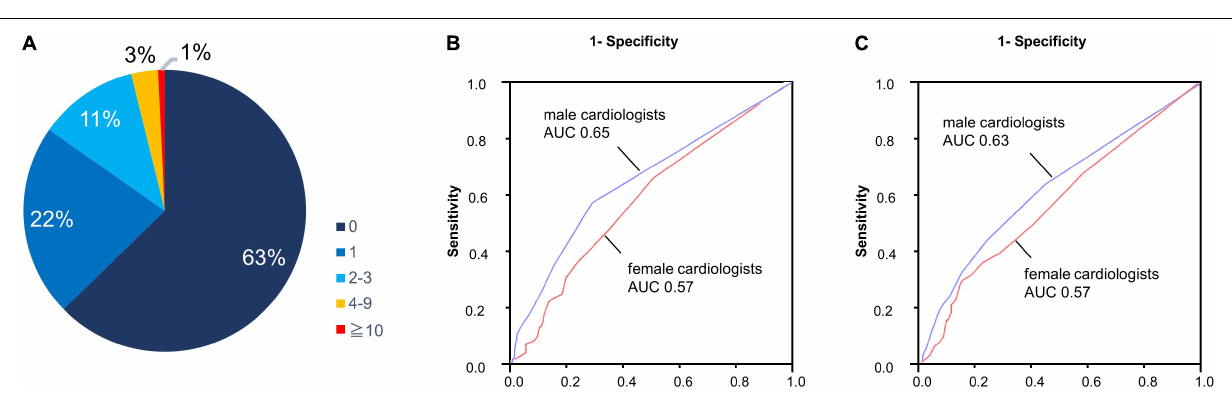
54% (female 23% and both 31%) of female cardiologists